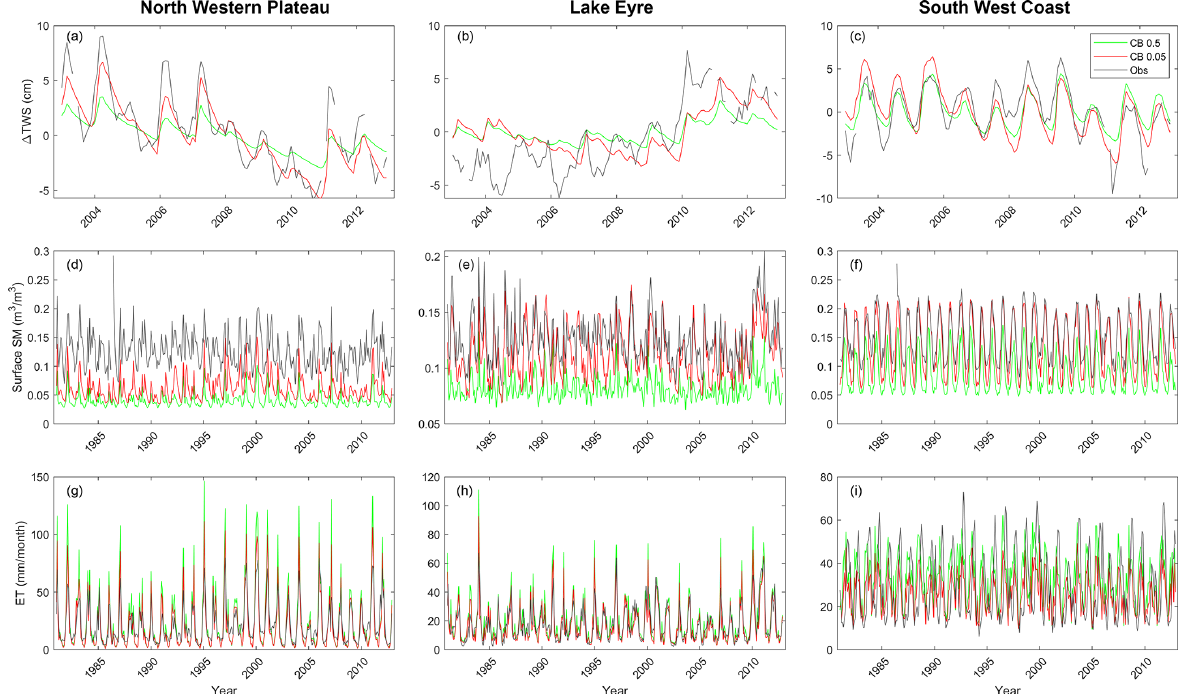
Figure 11. The change in terrestrial water storage ( (cid:49) TWS; a–c ), surface soil moisture (SSM; d–f ), and evapotranspiration (ET; g–i ) estimated from CABLE 0.5 ◦ (CB0.5), CABLE 0.05 ◦ (CB0.05), and remote sensing observations (Obs) over three different river basins, i.e., North Western Plateau (a, d, g) , Lake Eyre (b, e, h) , and South West Coast (c, f, i) , between 1981 and 2012. The remote sensing observations used for comparison are GRACE (TWS), ESA CCI (SSM), and GLEAM